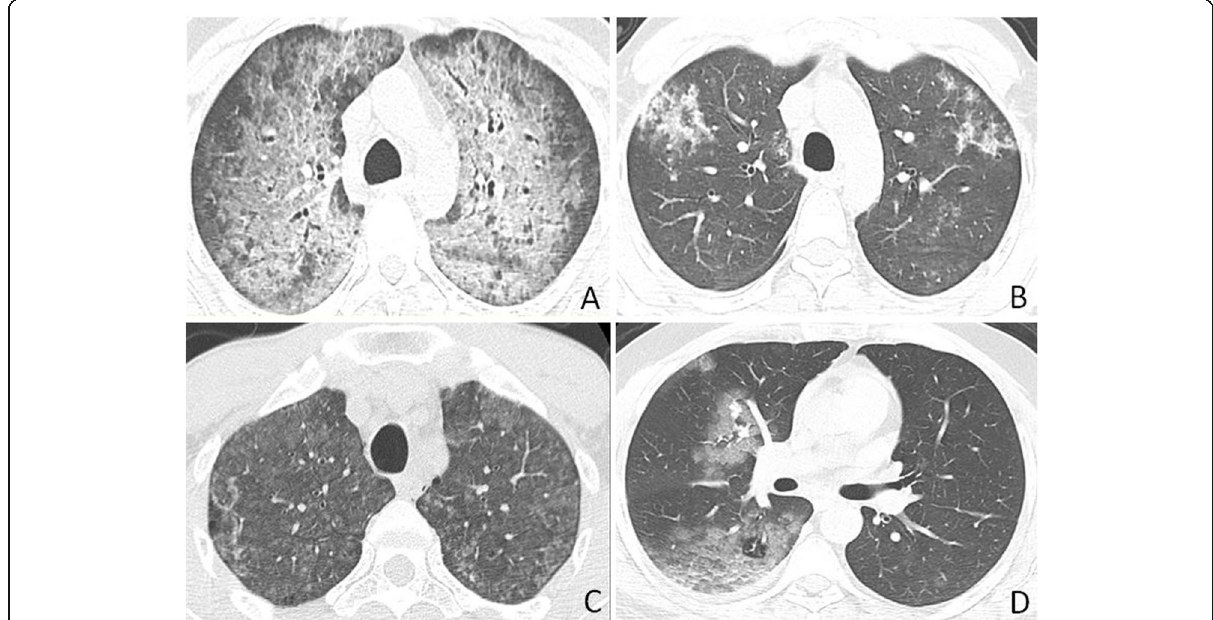
Fig. 6 Examples of conditions that were not mistaken as COVID-19. a Pneumocystis jiroveci pneumonia in a 33-year-old man with positive HIV test; axial CT image shows extensive bilateral ground-glass opacities with relative subpleural sparing. b Rhinovirius pneumonia in a 42-year-old woman; axial CT image shows multiple ill-defined patchy areas of GGO with left pulmonary nodules. c A 31-year-old farmer with subacute hypersensitivity pneumonitis; axial CT image shows patchy or diffuse bilateral ground-glass opacities associated with poorly defined centrilobular nodules. d A 66-year-old man with diffuse alveolar hemorrhage; axial CT image shows asymmetric bilateral patchy areas of